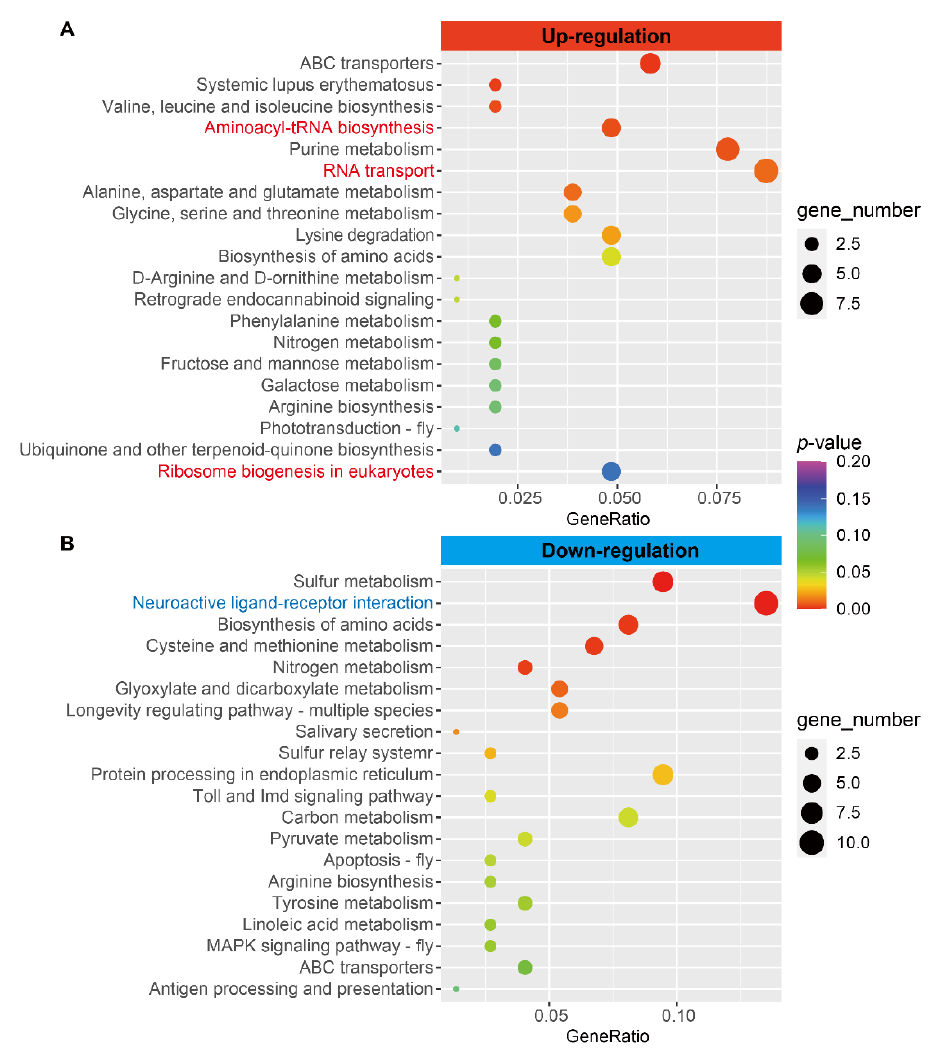
Figure 3. KEGG enrichment analysis for DEGs. ( A ) The top 20 enriched KEGG pathways for upregulated DEGs. ( B ) The top 20 enriched KEGG pathways for downregulated DEGs. Significance of enrichment is indicated by color from red to purple. Gene ratio is the ratio of the number of DEGs annotated to the KEGG pathway to the total number of DEGs.